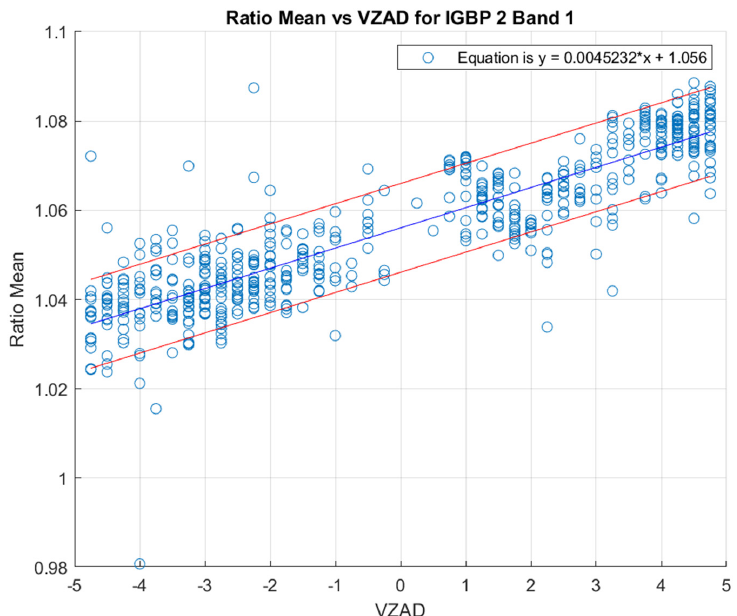
Figure 14. VZAD intercept estimator. Note there are no data at 0° VZAD, but the linear fit equation compensates for that, shown in the top right of the graph. The blue line is the model while the red lines depict the 68% confidence interval.